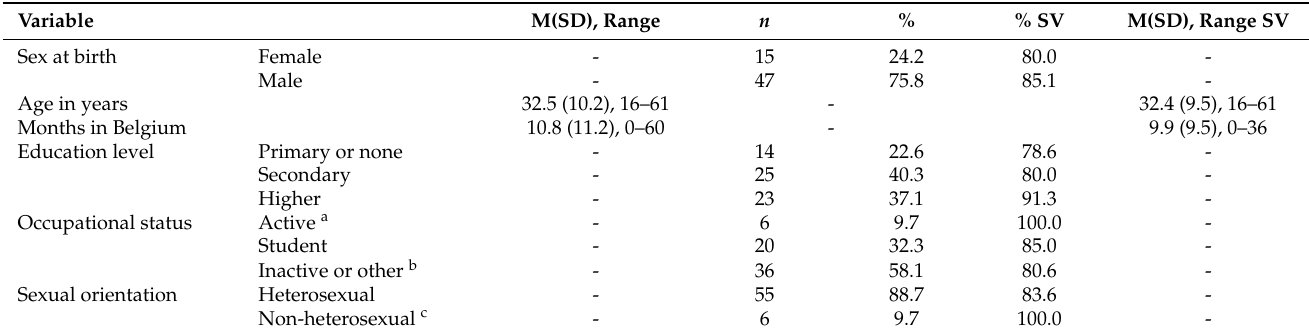
Table 1. Sociodemographic characteristics of the study population ( n =